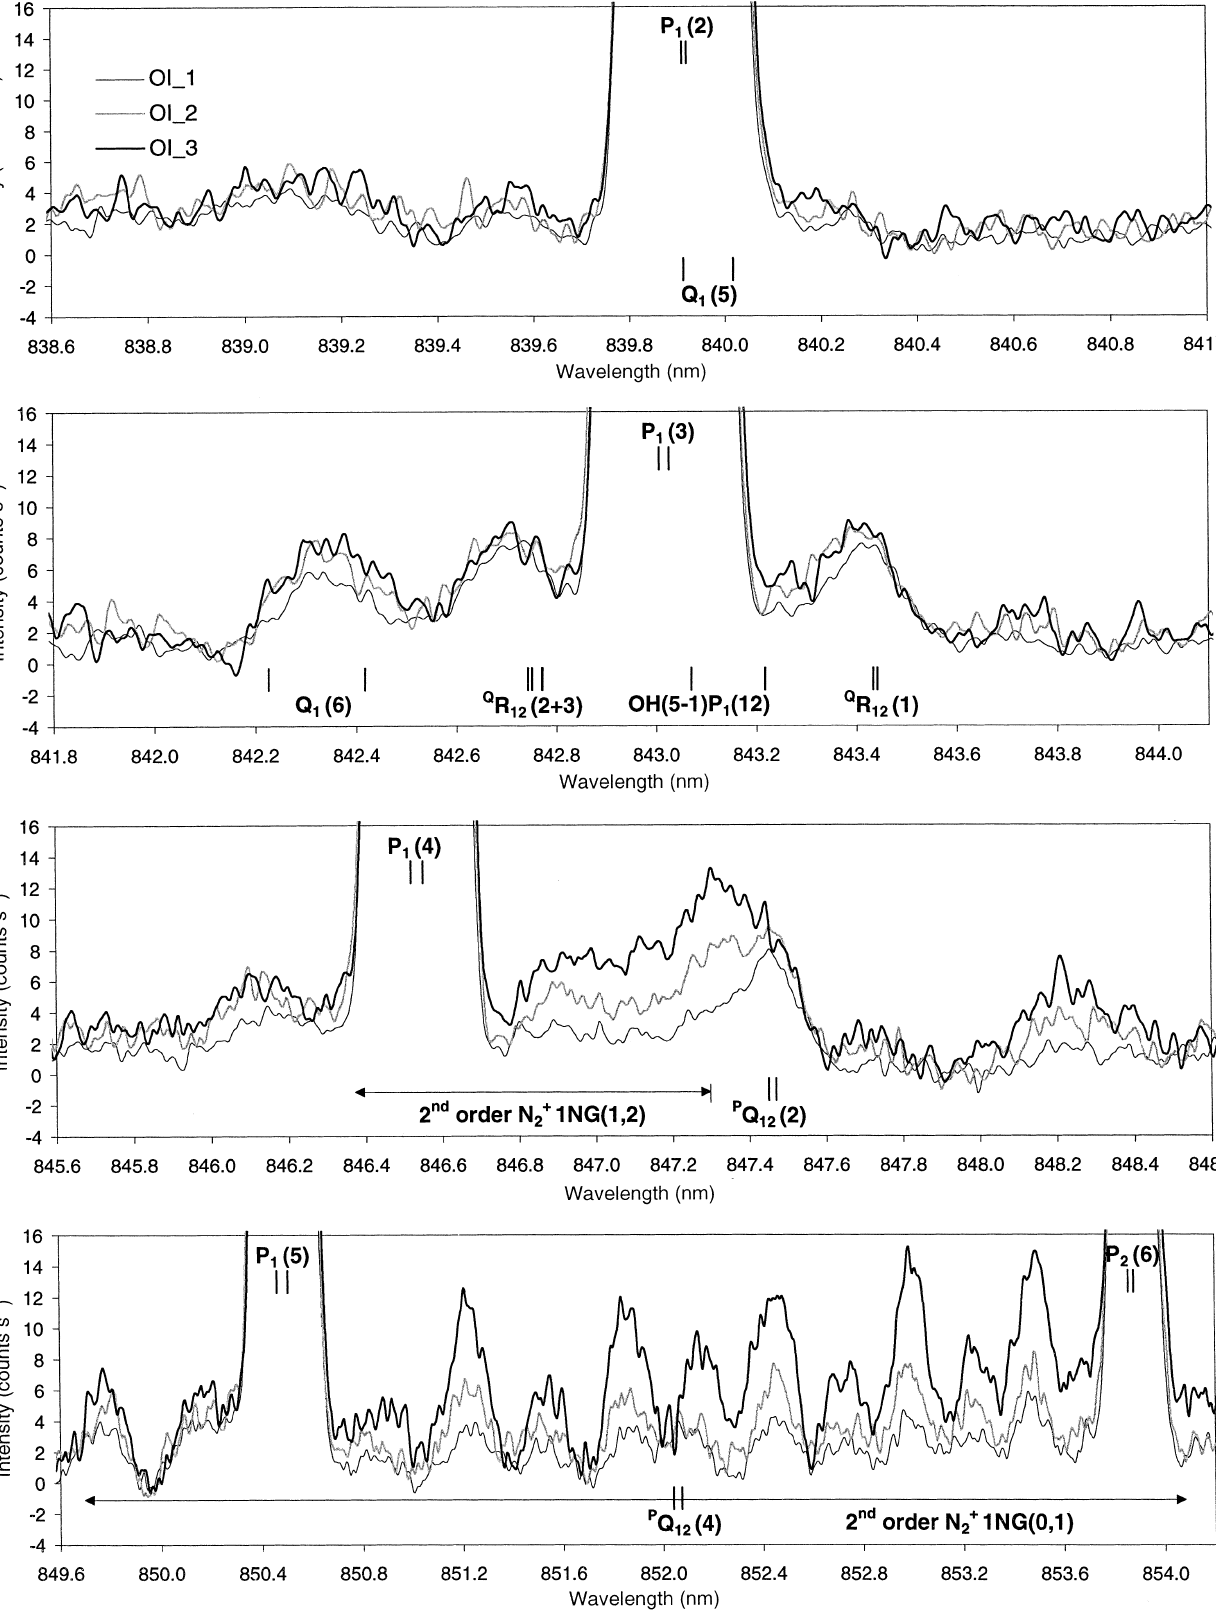
band. The main P branch features, their intensity truncated at 16 counts s (cid:255) 1 , are labelled. Identification of weak spectral features is made below the